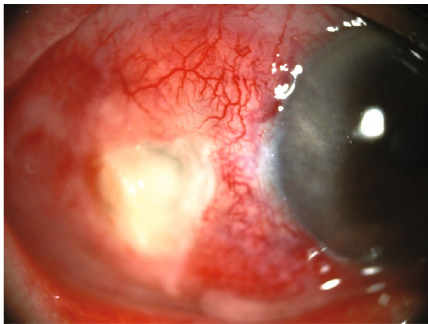
Figure 3: Slit-lamp photograph of the right eye of case 3 demonstrated severe eyelid swelling, marked chemosis, and scleral necrotic scleral ulcer size of 3 × 4 mm with calci fi ed plaques at the nasal side of the previous pterygium